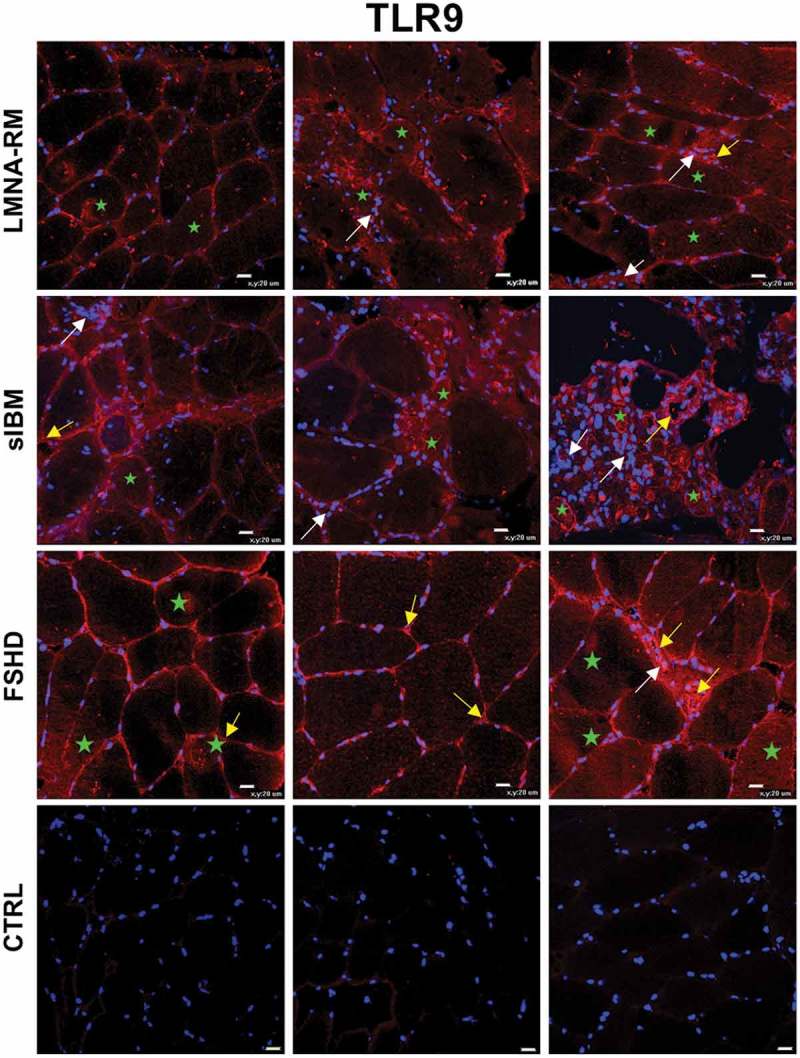
TLR9 expression and localization in LMNA-RM, sIBM, FSHD patients and non-myopathic control (CTRL) muscle tissues. All myopathic samples showed a positive immunoreactivity for TLR9. The receptor was mainly detected in the endomysial space, on the sarcolemma and sometimes within myofibers (green stars), on inflammatory cells (white arrows) and on capillaries and small blood vessels (yellow arrows). A weak or negative staining was observed in control muscle tissues. Original magnification, X40; bar 20 μm.